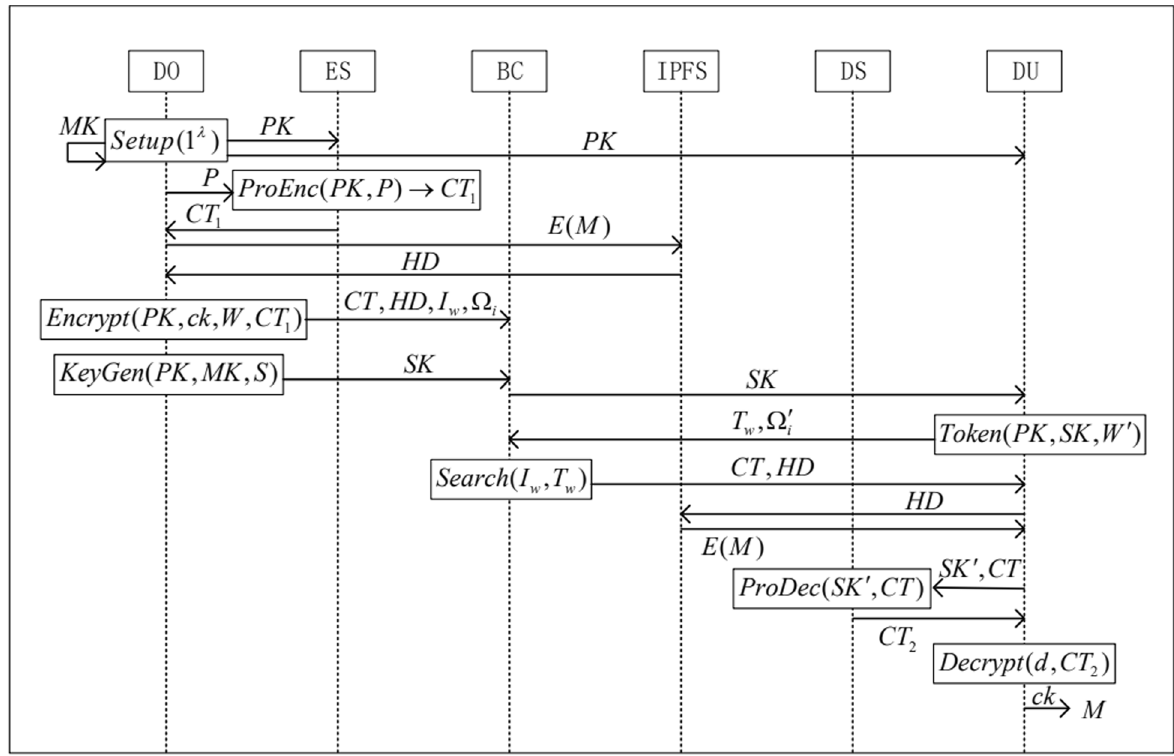
Fig. 2 The workflow of the proposed